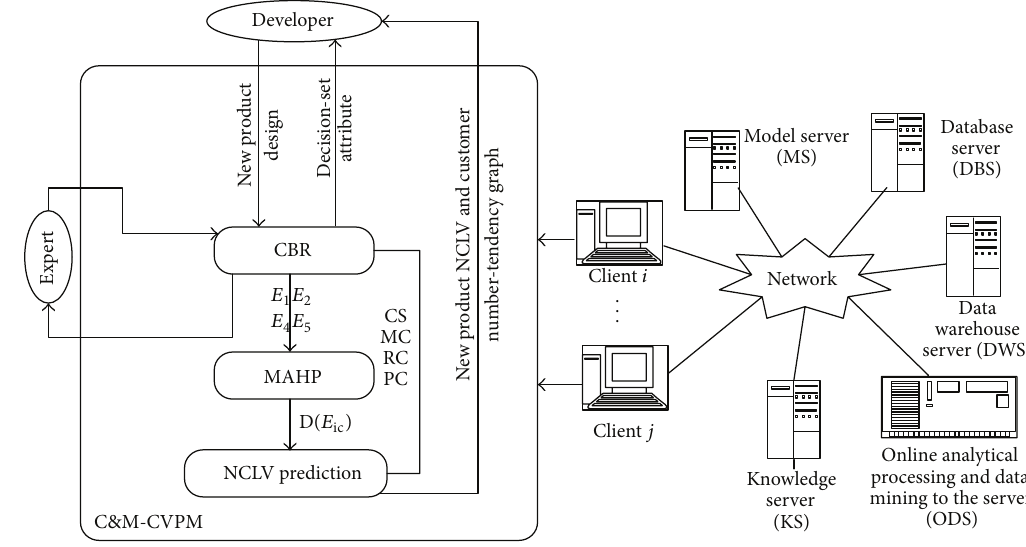
Figure 2: The system framework of